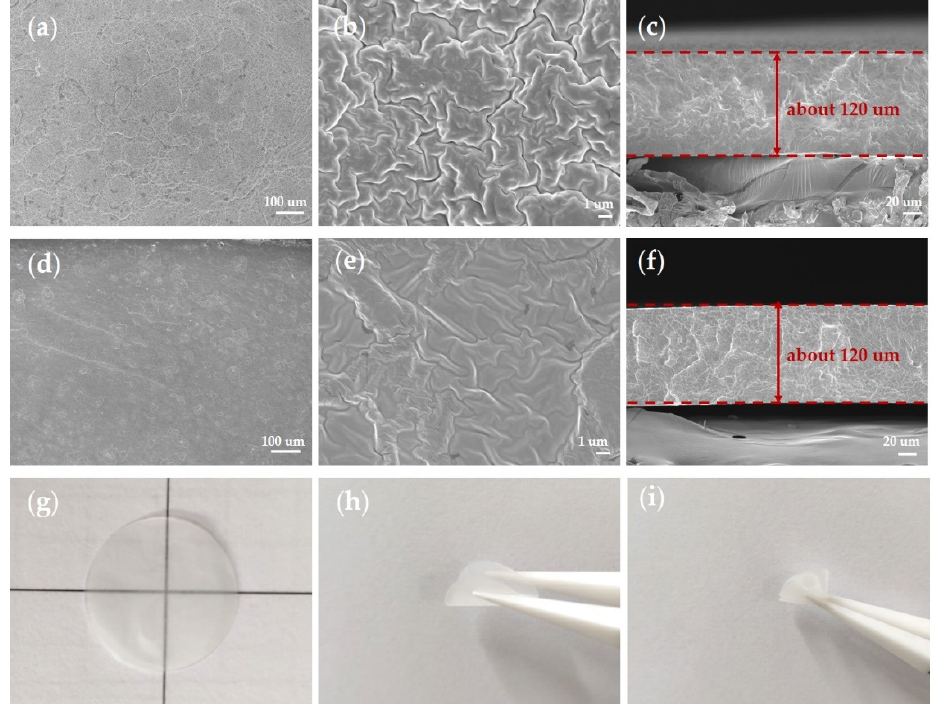
Figure 4. ( a – c ) SEM images of 10% p-V-SiO 2 /PEO CPE. ( d – f ) SEM images of 10% p-SiO 2 /PEO CPE. ( g ) Optical images of the 10% p-V-SiO 2 /PEO CPE. ( h ) bent 10% p-V-SiO 2 /PEO CPE. ( i ) twisted 10% p-V-SiO 2 /PEO CPE.